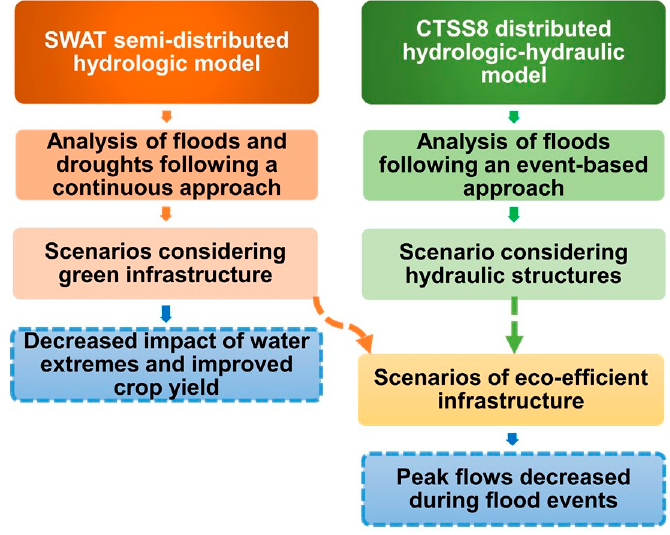
Figure 4. Methodological flow chart.